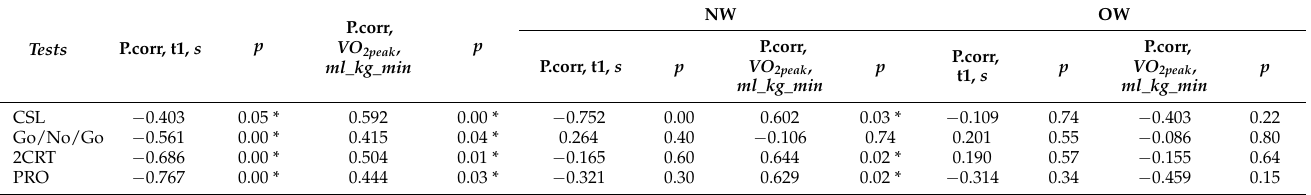
Table 5. Correlation between oxygen uptake kinetics, VO 2 peak, and cognitive function test